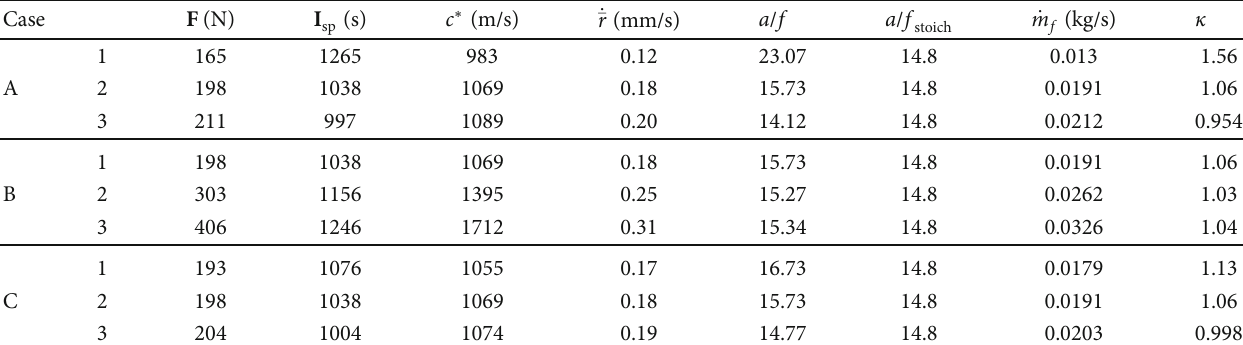
Figure 21: Distributions of the heat release rate at the fl ame surface for the cases with di ff erent inlet conditions. Table 4: Thermodynamic parameters for the cases with di ff erent inlet